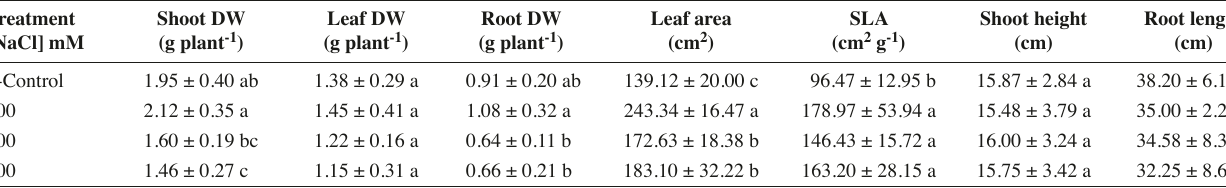
Tab. 1: Growth parameters in iceplant subjected to different salt conditions.